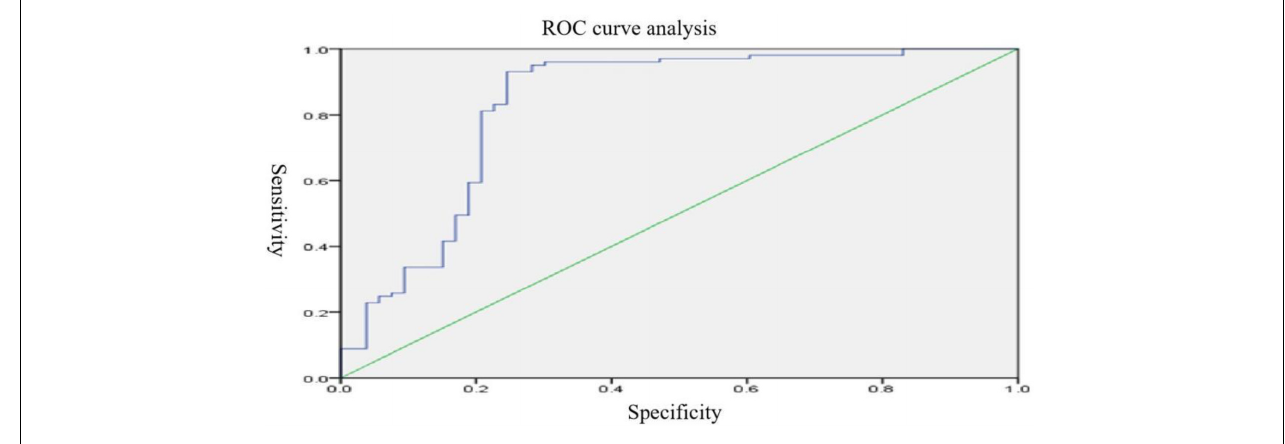
FIGURE 4 | | Resting-state ROC curves for major depressive disorder (MDD).